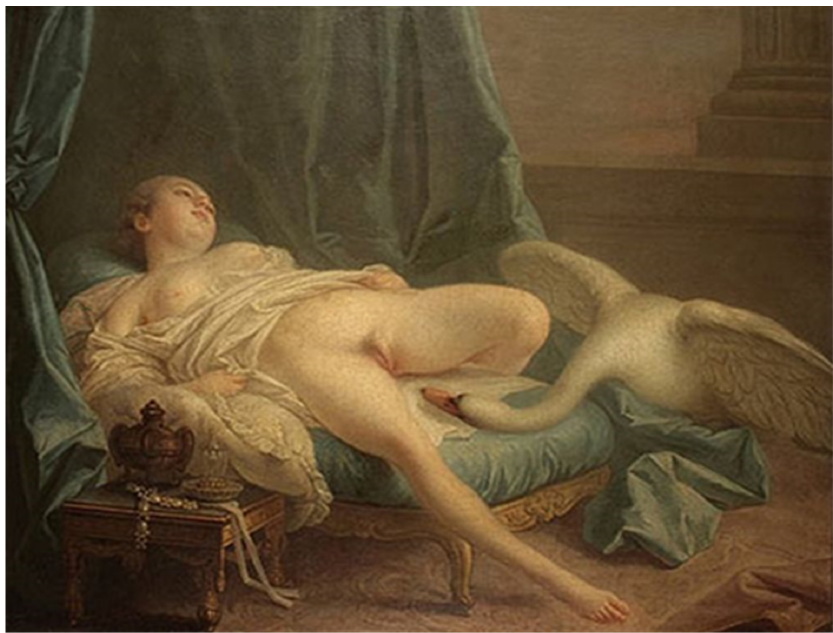
Figure 13. François Boucher. Leda and the Swan (1740).